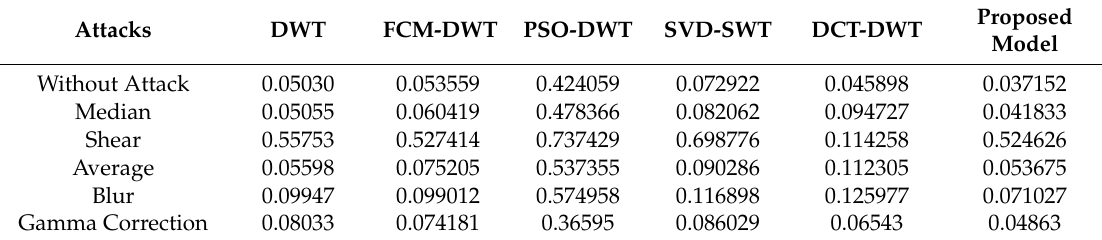
Table 2. Bit error rate (BER) values of di ff erent models and the proposed model after extracting the